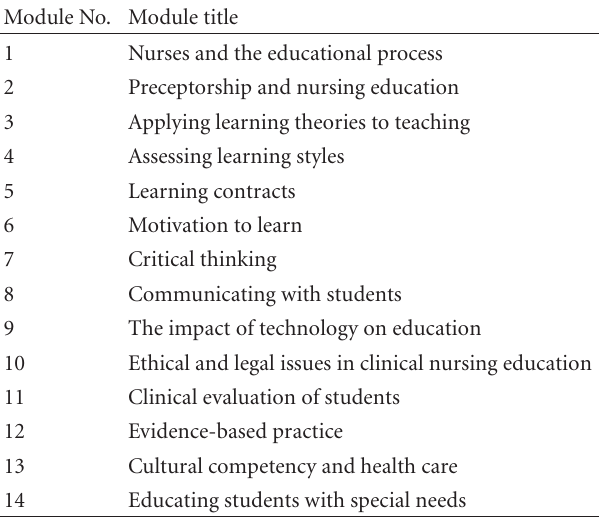
Table 1: Online Modules Available to Nurse Preceptors. Module No. Module